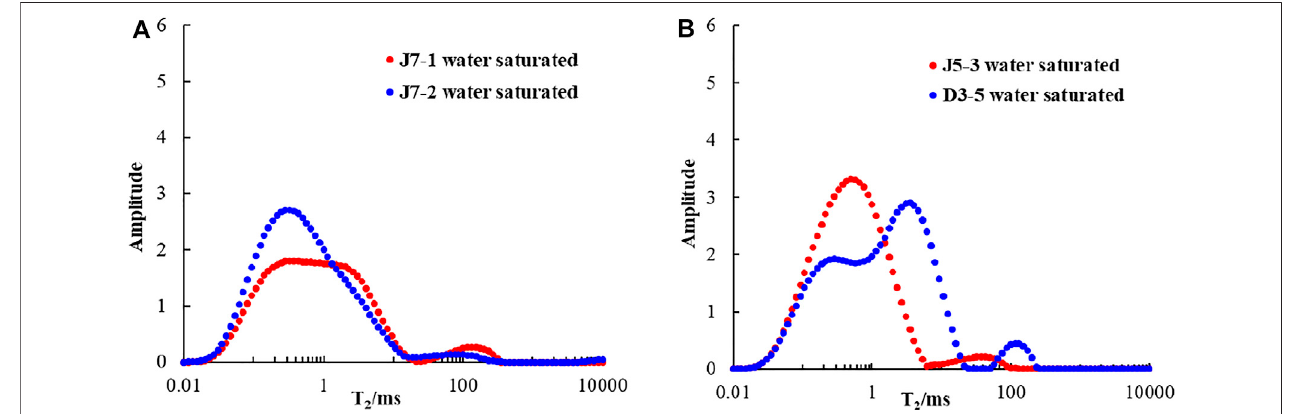
FIGURE 9 | Resistivities of 26 shale samples in an oven-dried and water-saturated states.